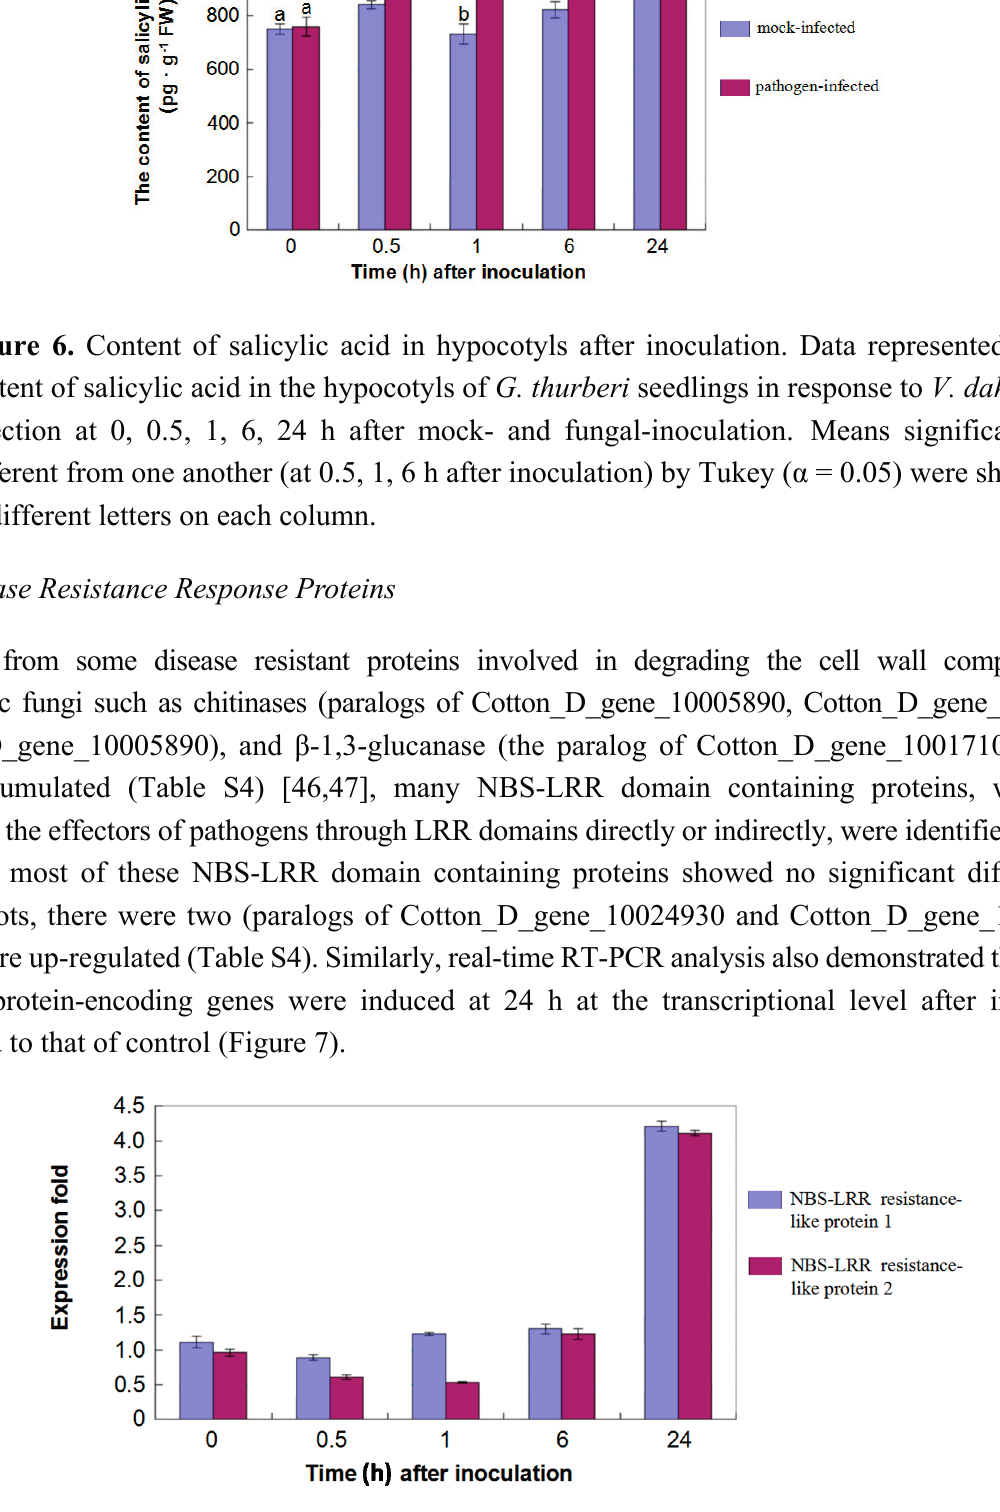
Figure 7. Expression pattern of 2 NBS-LRR-like protein encoding genes. Data showed the real-time RT-PCR analysis of two up-regulated protein encoding genes in response to infection at 0, 0.5, 1, 6, 24 h after mock- and